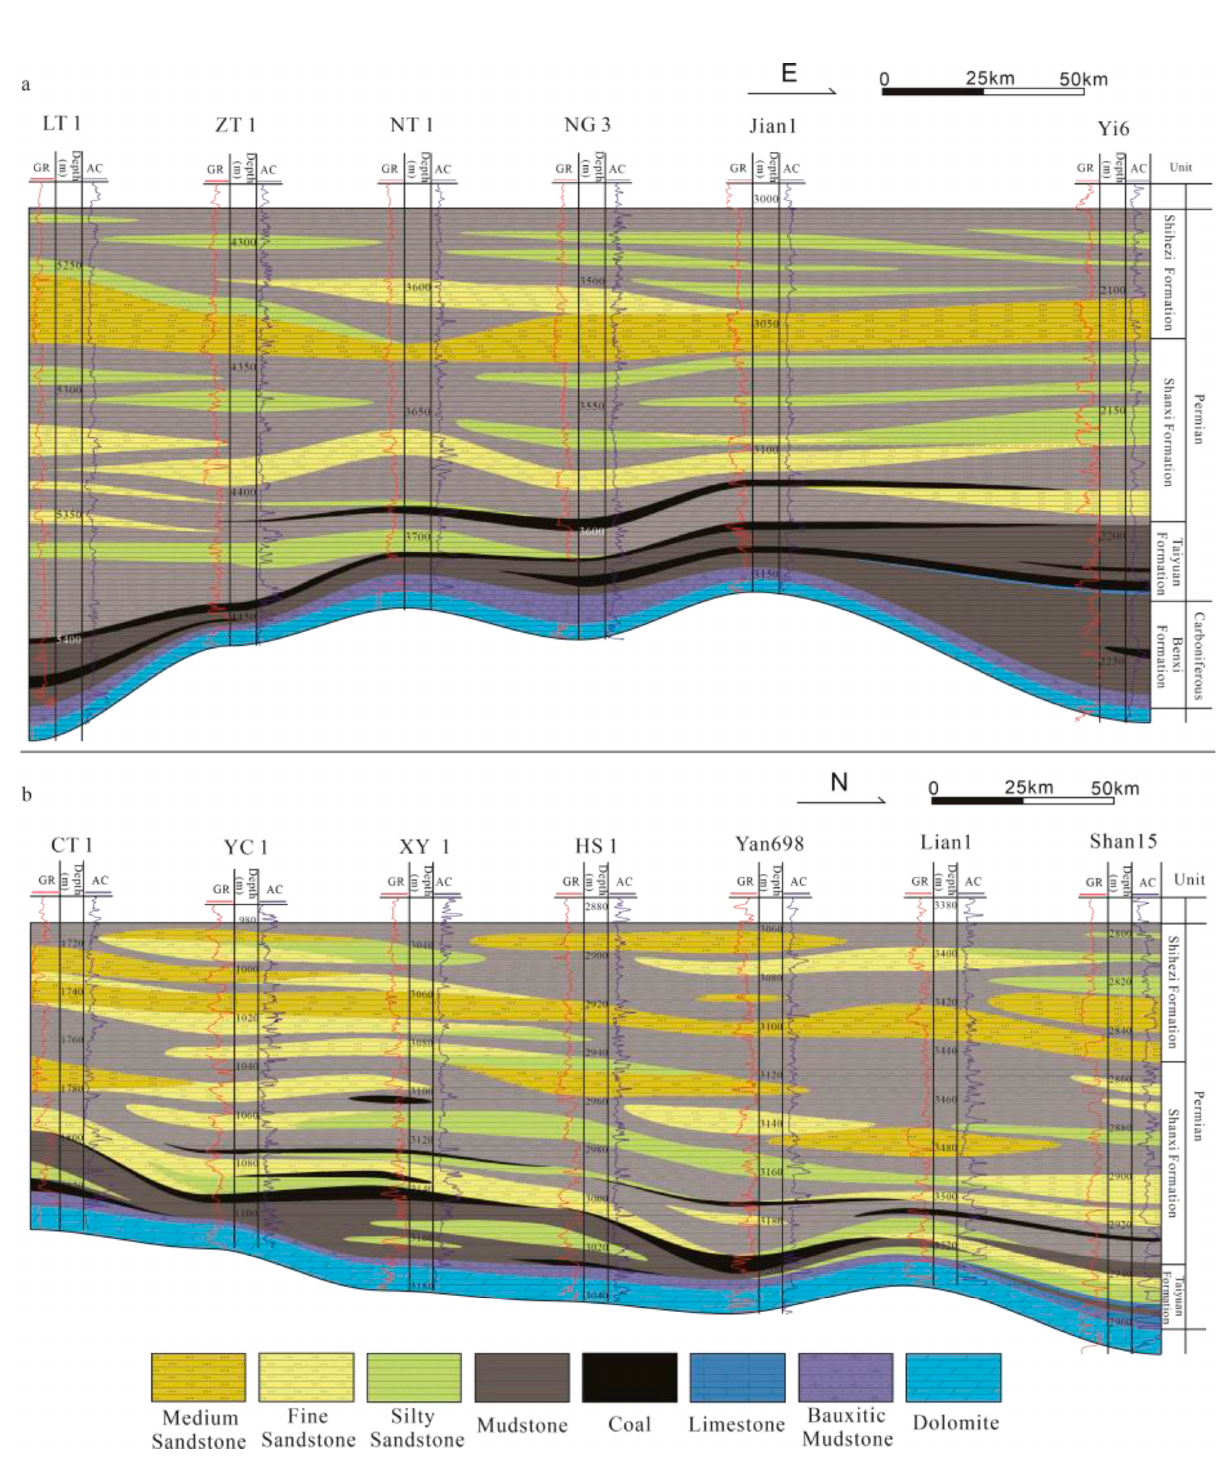
Figure 5. Schematic geological sections of the Upper Palezoic rocks in the Ordos Basin ( a ). Schematic geological section of A—A’ cross-section; ( b ). Schematic geological section of B—B’ cross-section. A—A’ cross-section connected by LT1—ZT1—NT1—NG3—Jian1—Yi6; B—B’ cross-section connected shown in Figure 2. SP: wireline logging of the spontaneous potential; GR: wireline logging of the natural gamma response.